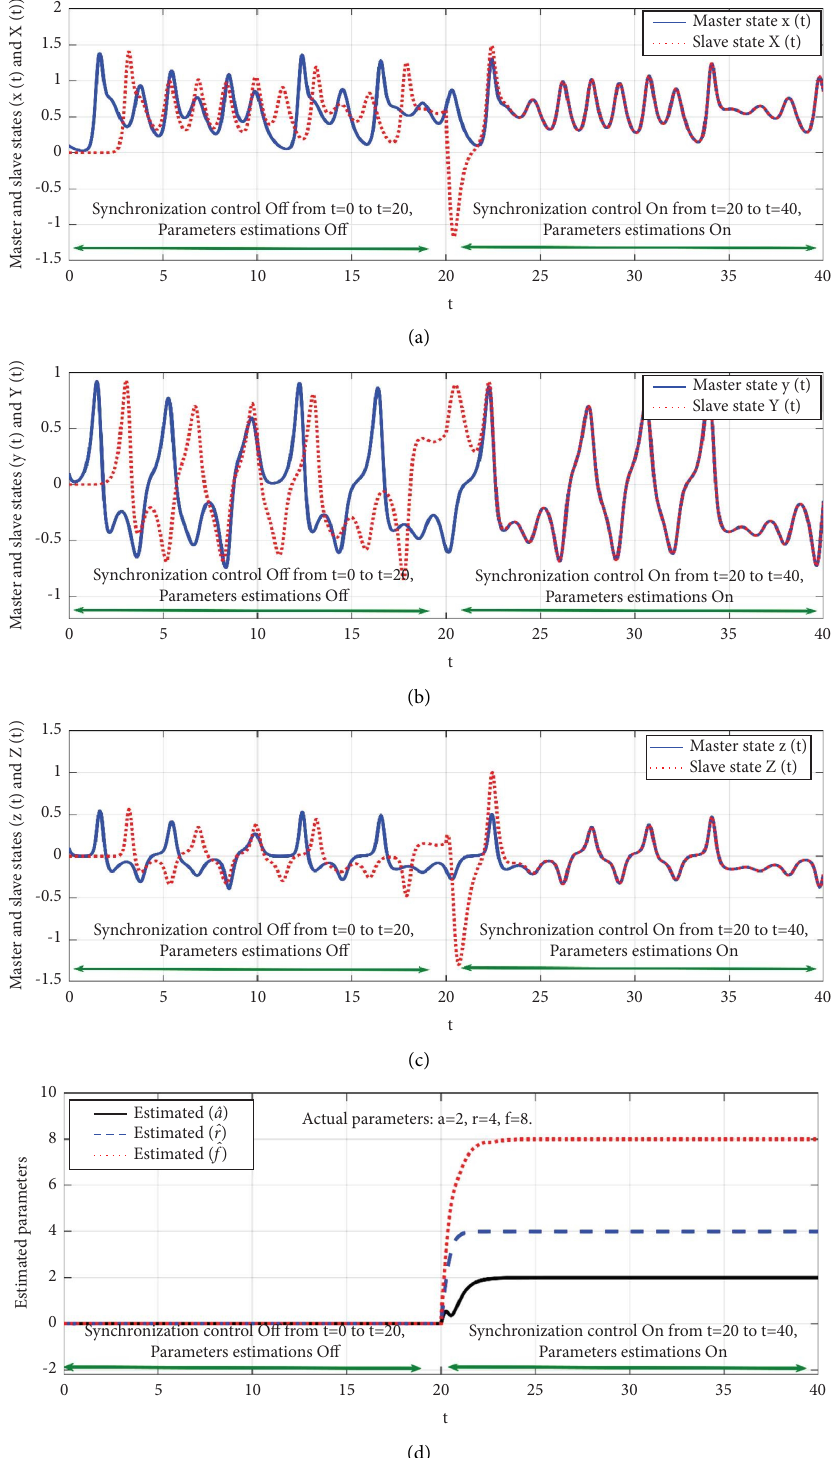
Figure 12: Te evolution of the system time response before and after chaos synchronization when a � 2 ,b � 7 ,r � 4 ,g � 11 ,f � 8 ,c � 5, control gains α i � β i � 2 . 0 , ( i � 1 , 2 , 3 ) , and initial conditions x ( 0 ) � y ( 0 ) � z ( 0 ) � 0 . 1 ,X ( 0 ) � Y ( 0 ) � Z ( 0 ) � 0 . 0001 , 􏽢 a ( 0 ) � 􏽢 r ( 0 ) � 􏽢 f ( 0 ) � 0 . 0. (a–c) the evolution of both the master-slave systems states x ( t ) , y ( t ) ,z ( t ) , X ( t ) ,Y ( t ) , and Z ( t ) before chaos synchronization on 0 ≤ t < 20 and after chaos synchronization on 20 ≤ t ≤ 40 and (d) the evolution of the system estimated parameters 􏽢 a, 􏽢 r, and 􏽢 f